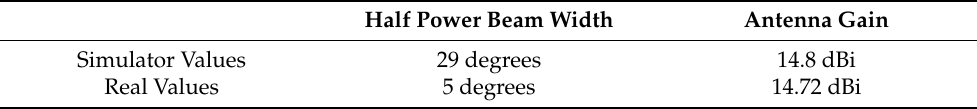
Table 1. Spectral power density of different